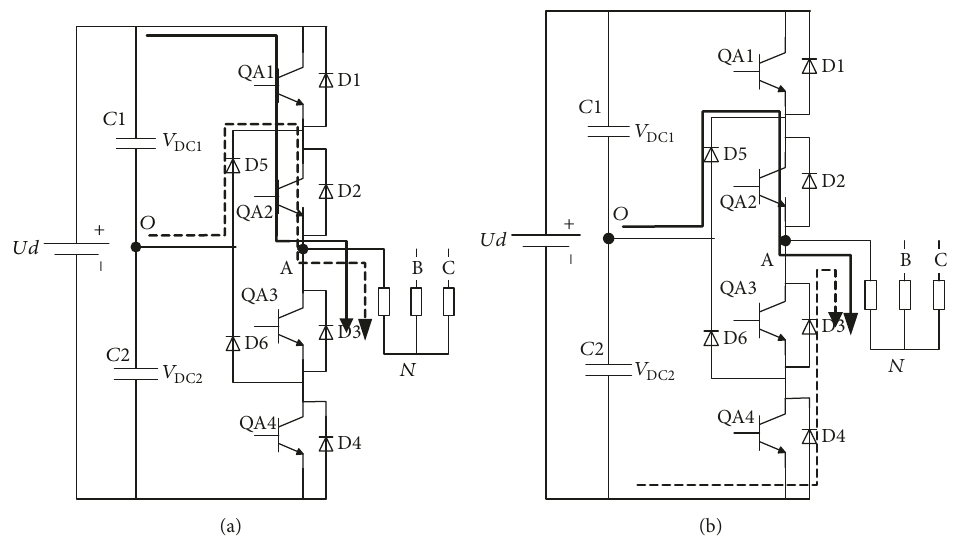
Figure 3: Change of current paths under open circuit fault. (a) QA1 fault. (b) QA2 fault.